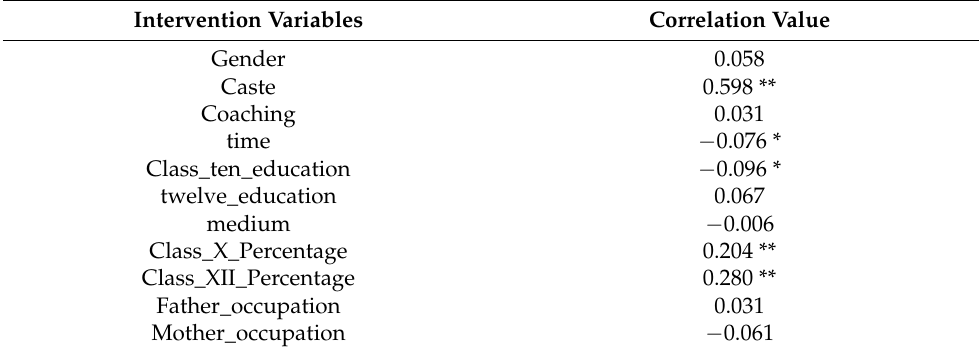
Table 10. Correlation values between intervention and response variables.